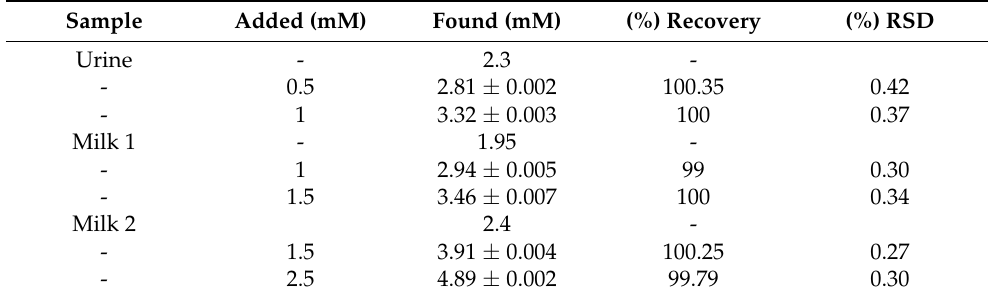
Table 2. Percent recovery and direct quantification of urea from milk, and urine real sample